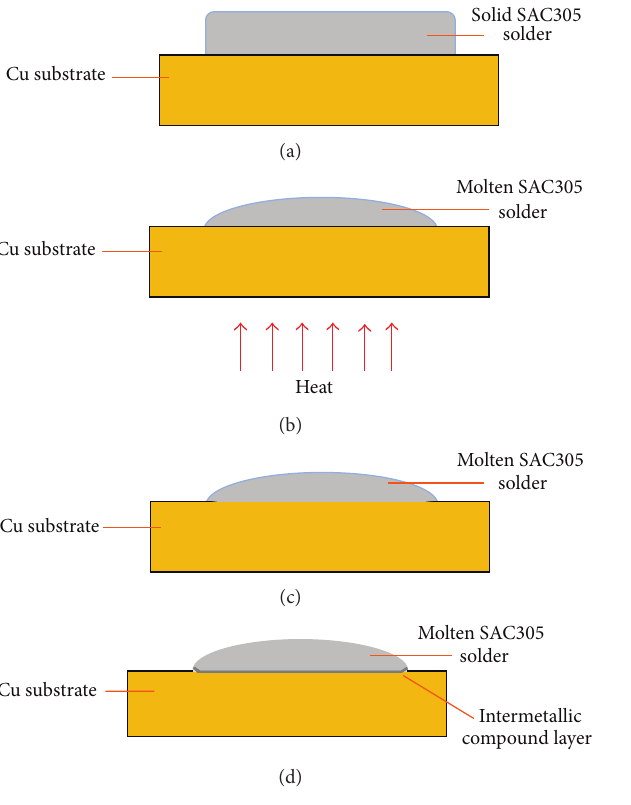
Figure 2: Solder wetting process: (a) SAC305 solder on the Cu substrate, (b) liquid solder spreading over the Cu substrate during soldering, (c) Cu diffuse in the liquid solder, and (d) Cu reacting with the liquid solder to form an intermetallic compound